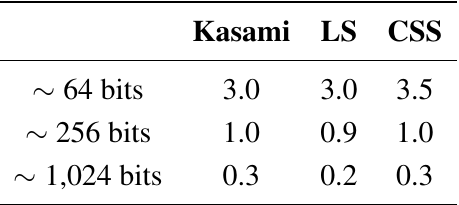
is 0.5 (transducer response and atmospheric AC